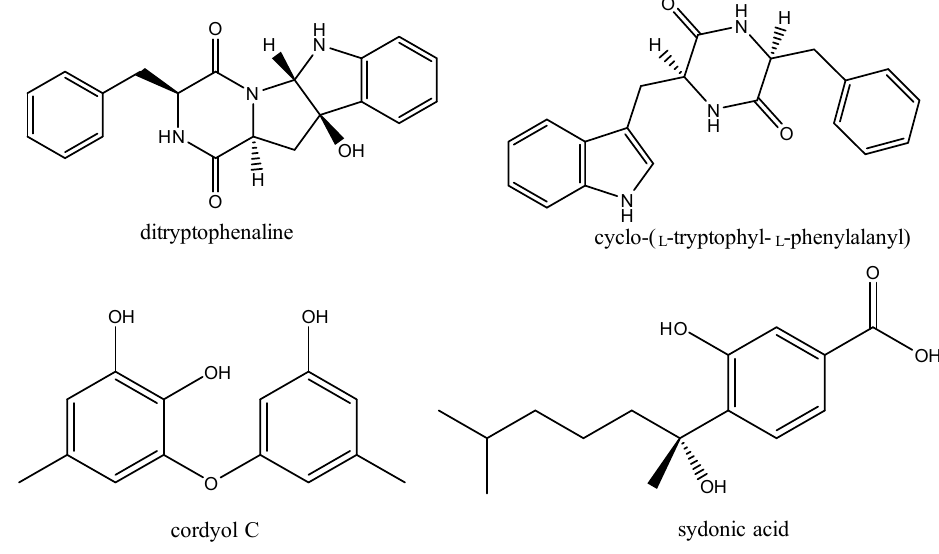
Figure 3. Structures of known compound s .